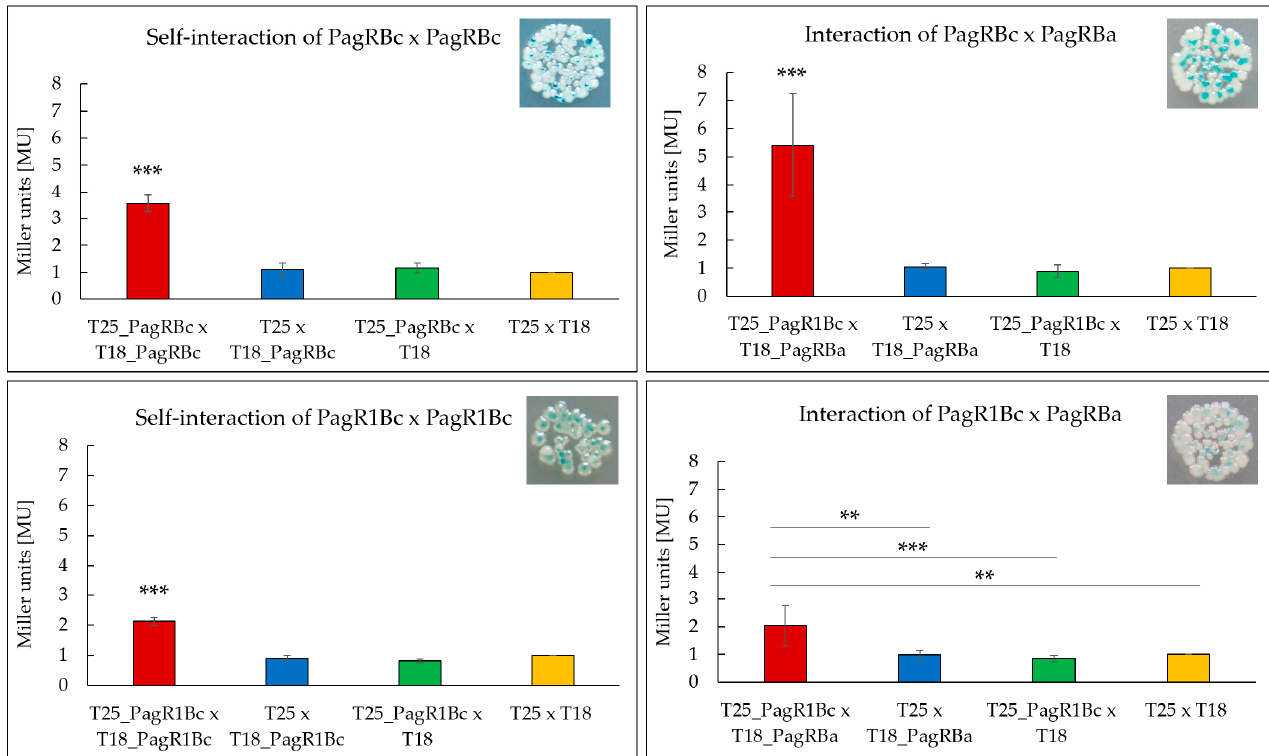
Figure 4. Screening of interacting PagR homologues of emetic B. cereus F4810/72 and B. anthracis Sterne strain by a Bacterial Two-Hybrid System Assay (BACTH assay). Self-interactions of the PagR proteins PagRBc and PagR1Bc are shown as well as the interactions of PagRBc × PagRBa and PagR1Bc × PagRBa. The efficacies of complementation between the indicated hybrid proteins were quantified by β -galactosidase assay (in Miller units [MU]). A color change to blue of the colonies indicates an interaction, respectively. Representative results from three independent experiments are shown, respectively. Statistically significant differences between the sample compared to the three controls are denoted as follows: ** p < 0.01, *** p < 0.001.